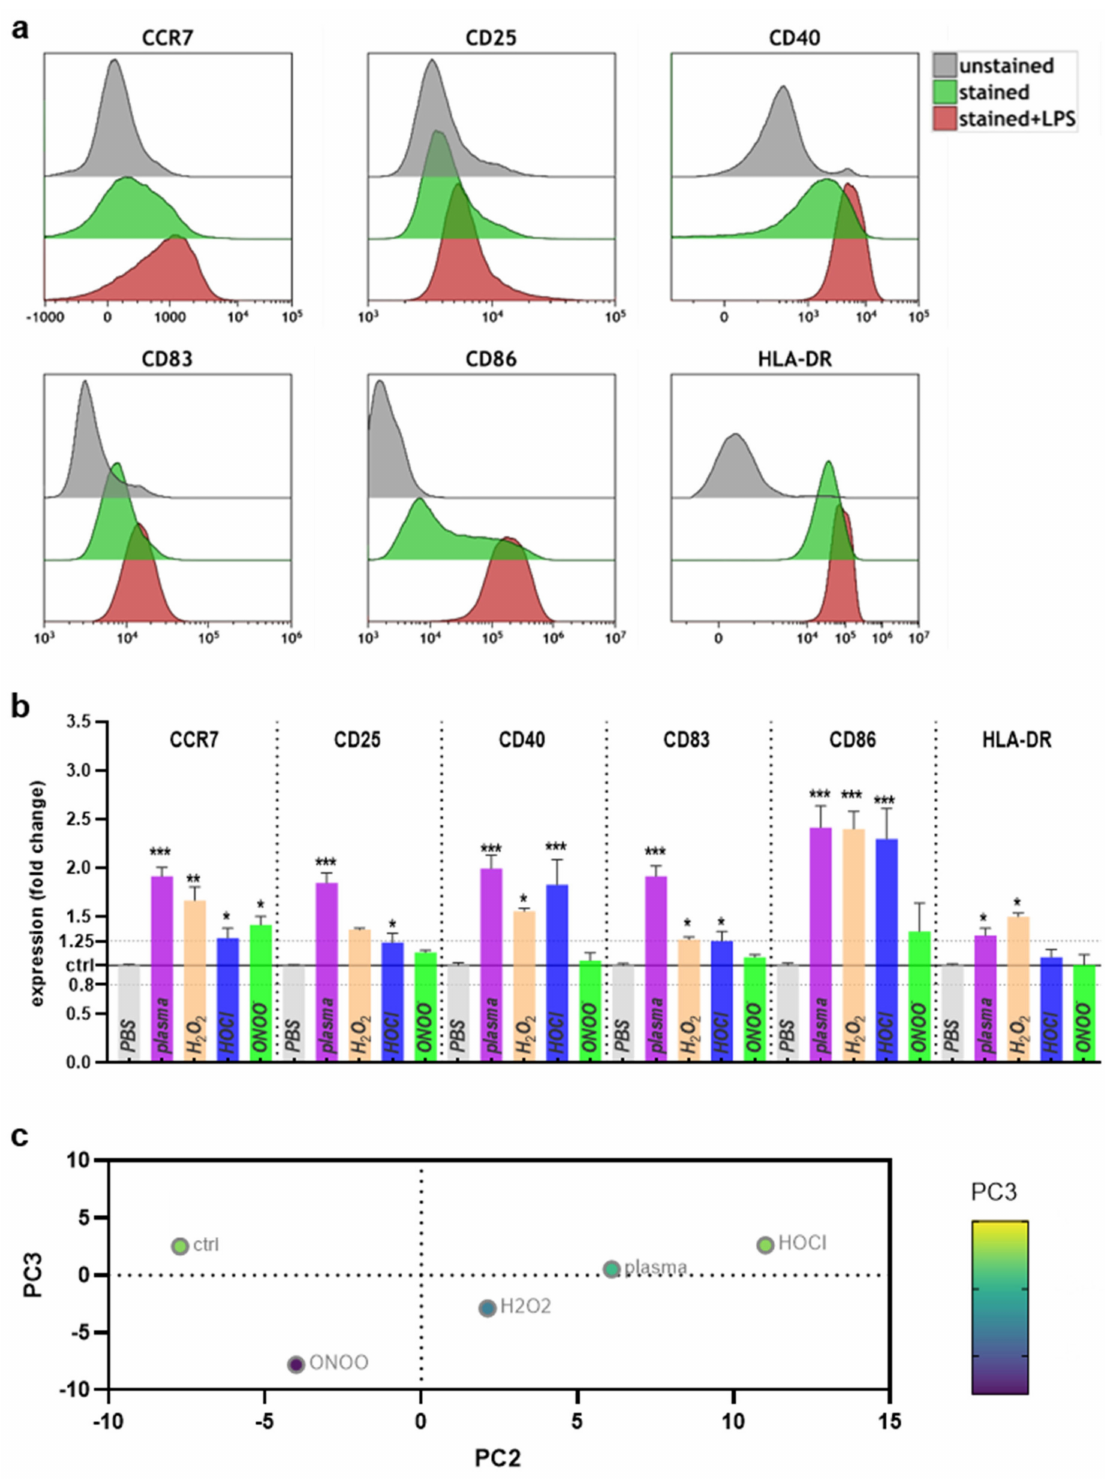
Figure 3. Argon plasma treatment and ROS/RNS modulate the surface marker expression profiles. ( a ) overlay histograms of several cell surface markers of unstained, stained, stained, and LPS-pulsed human moDCs; ( b ) quantification and fold-change differences in human moDCs treated as indicated and analyzed 24 h later; ( c ) data summary using principal- component analysis. Data are mean and standard error of 3–6 different donors. Statistical analysis was done using one-way analysis of variances with p < 0.05 (*), p < 0.01 (**), and p < 0.001